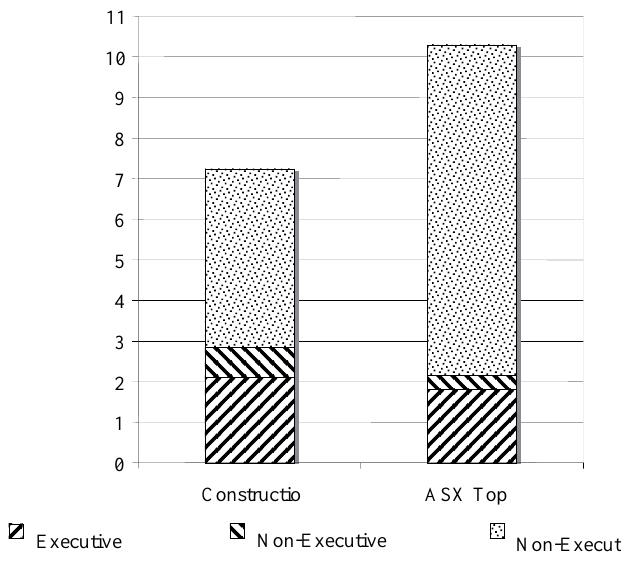
Figure 3: Independence levels